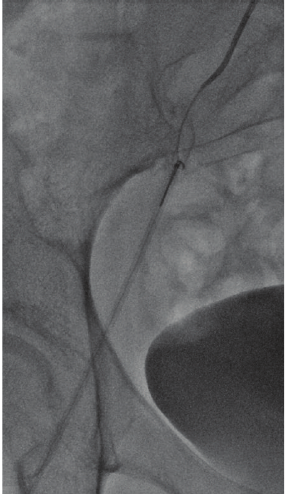
Figure 3: Wire retrieval from the right femoral sheath following recanalization of the right common iliac